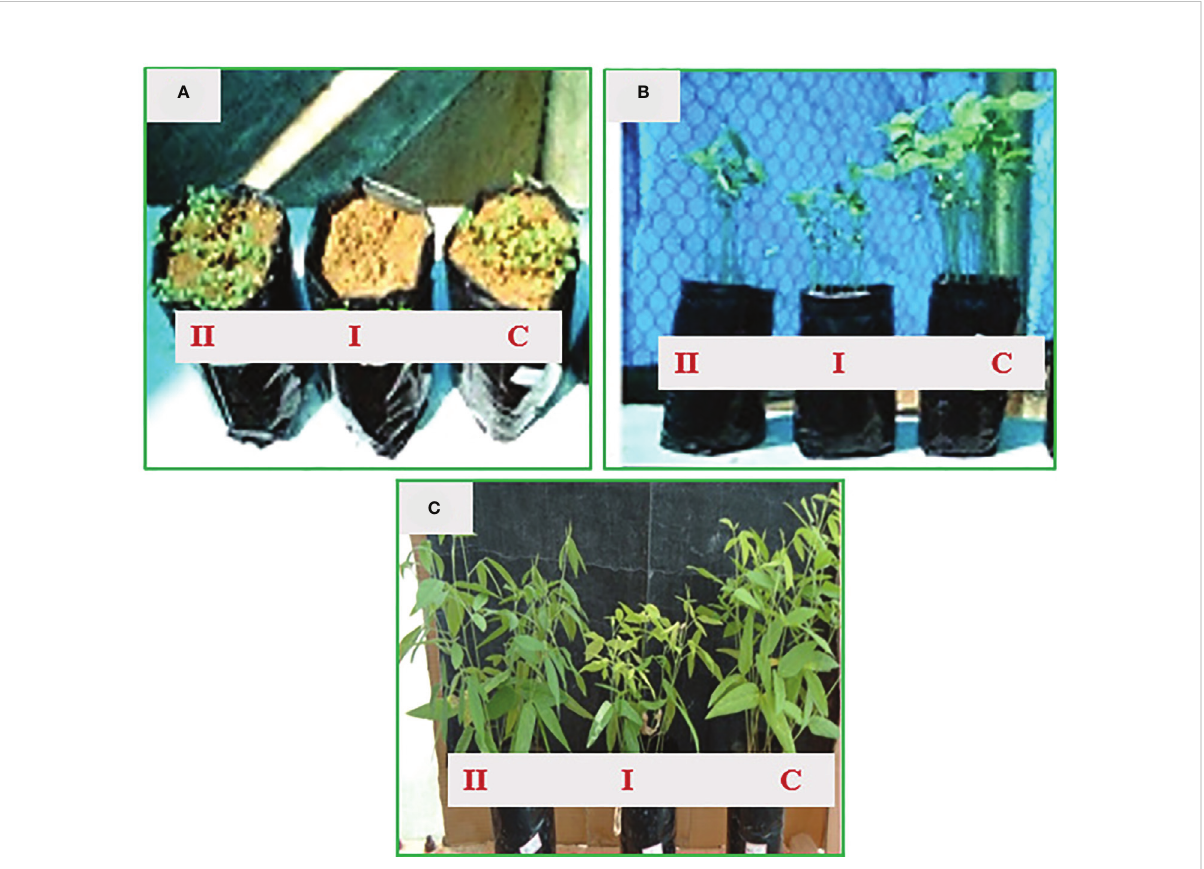
FIGURE 4 C. cajan ( L .) Millsp. grown under greenhouse experiment with different treatment groups and control. (A) 10th day; (B) 30th day; (C) 50th